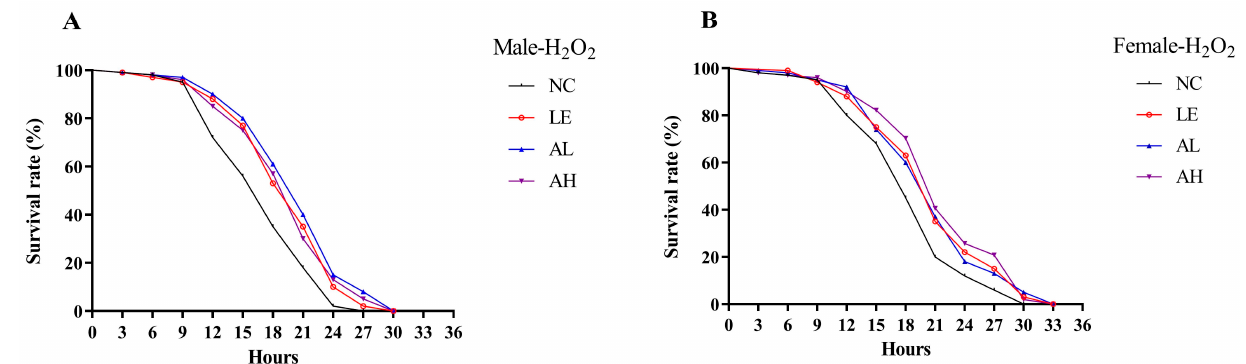
Figure 2. Effects of AAPS on H 2 O 2 treatment on the survival time of Drosophila melanogaster. ( A ) H 2 O 2 treatment of male ( B ) H 2 O 2 treatment of female. LE, 3 mg/mL Lentinan; AL, 3 mg/mL AAPS; AH, 9 mg/mL AAPS; ( n = 100 per group). Table 2. Effects of Agrocybe aegerita polysaccharide on the lifespan of H 2 O 2 treated Drosophila .